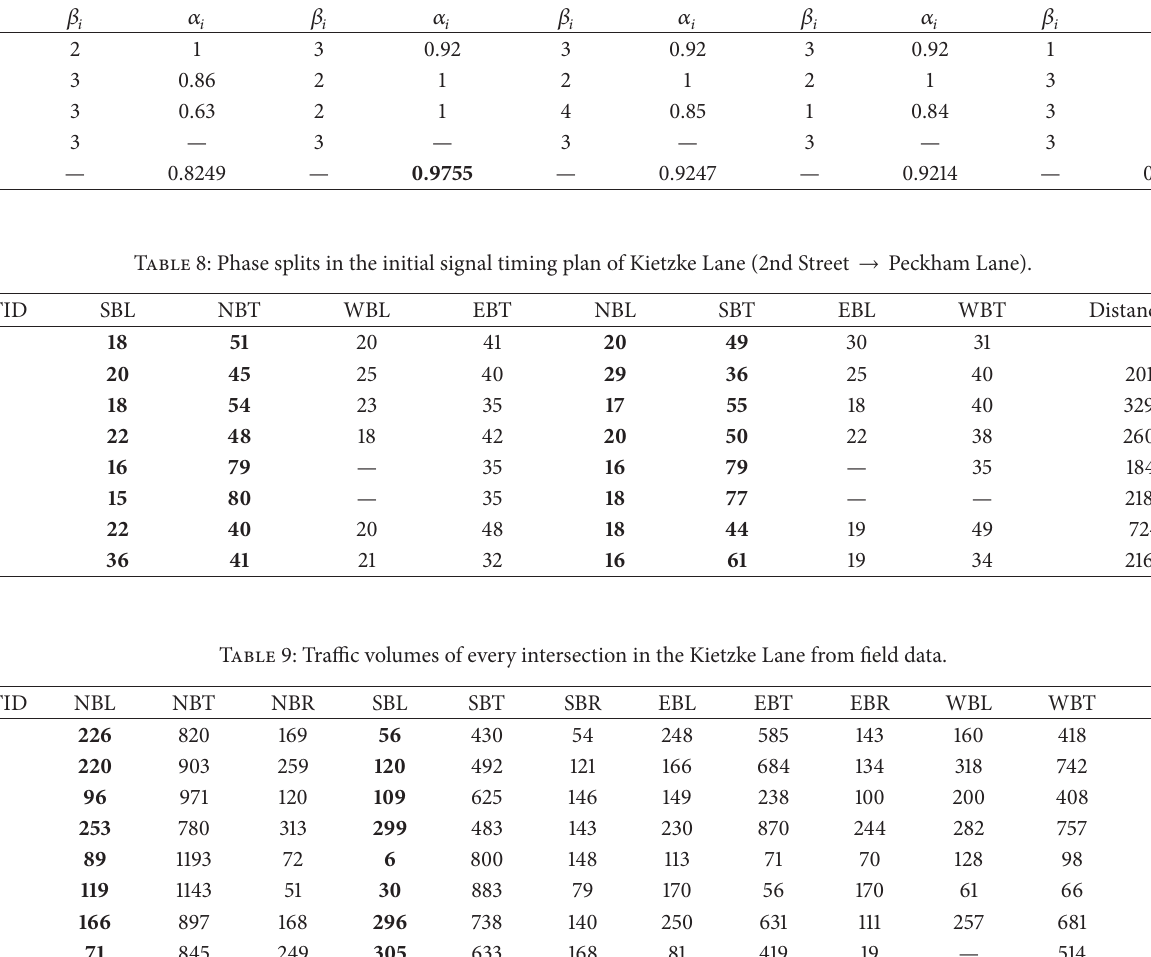
4.3. Optimized Results Using the Proposed Algorithm.